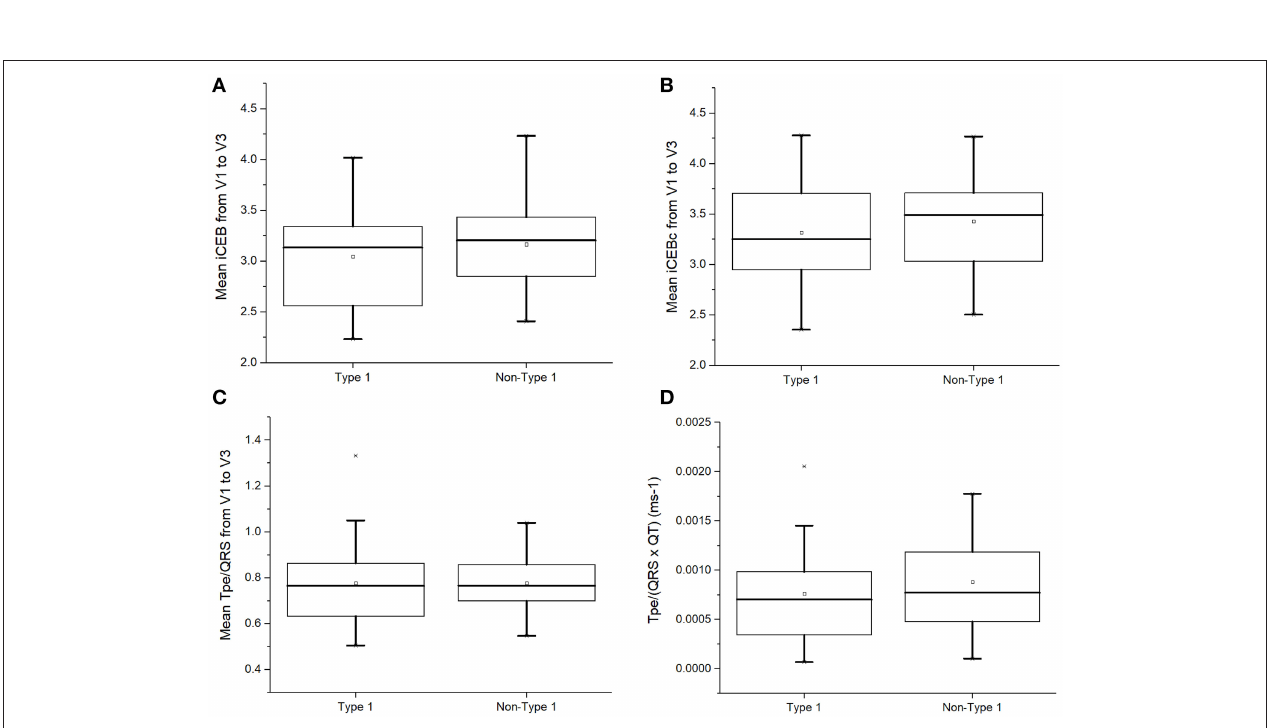
FIGURE 5 | Index of Cardiac Electrophysiological Balance (iCEB, QT/QRS) (A) , iCEB corrected for heart rate (QTc/QRS) (B) , T peak − T end /QRS (C), or T peak − T end /(QRS × QT) (D) in type 1 and non-type 1 Brugada syndrome patients.